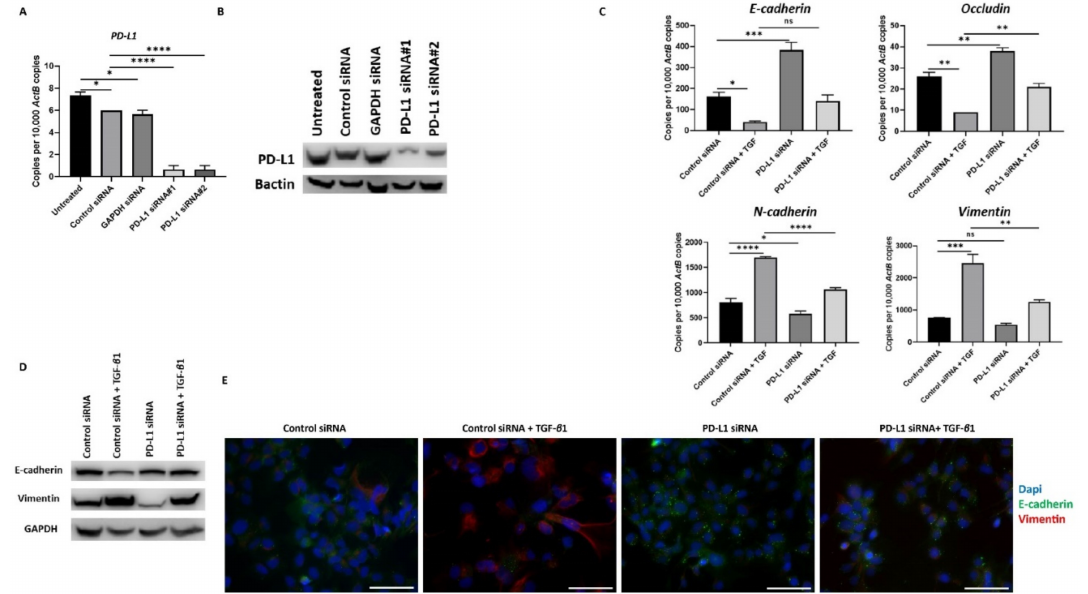
Figure 7. Silencing of PD-L1 reverses TGF- β 1-mediated EMT in Hep3B cells. ( A , B ) Transfection of Hep3B cells with two specific PD-L1 siRNA effectively knockdown PD-L1 expression as demonstrated by qRT-PCR and western blot analysis. Bactin was used as the loading control. Silencing of PD-L1 resulted in increased E-cadherin and Occludin expression along with reduction in N-cadherin and Vimentin expression in Hep3B cells as assessed by ( C ) qRT-PCR and ( D ) western blot analysis. GAPDH was utilised as the loading control. ( E ) Fluorescence microscopy showed an increase in E-cadherin and a decrease in Vimentin following PD-L1 knockdown in Hep3B cells (scale bar = 200 µ m). ( n = 3, * p < 0.05, ** p < 0.01, *** p < 0.005, **** p < 0.001).